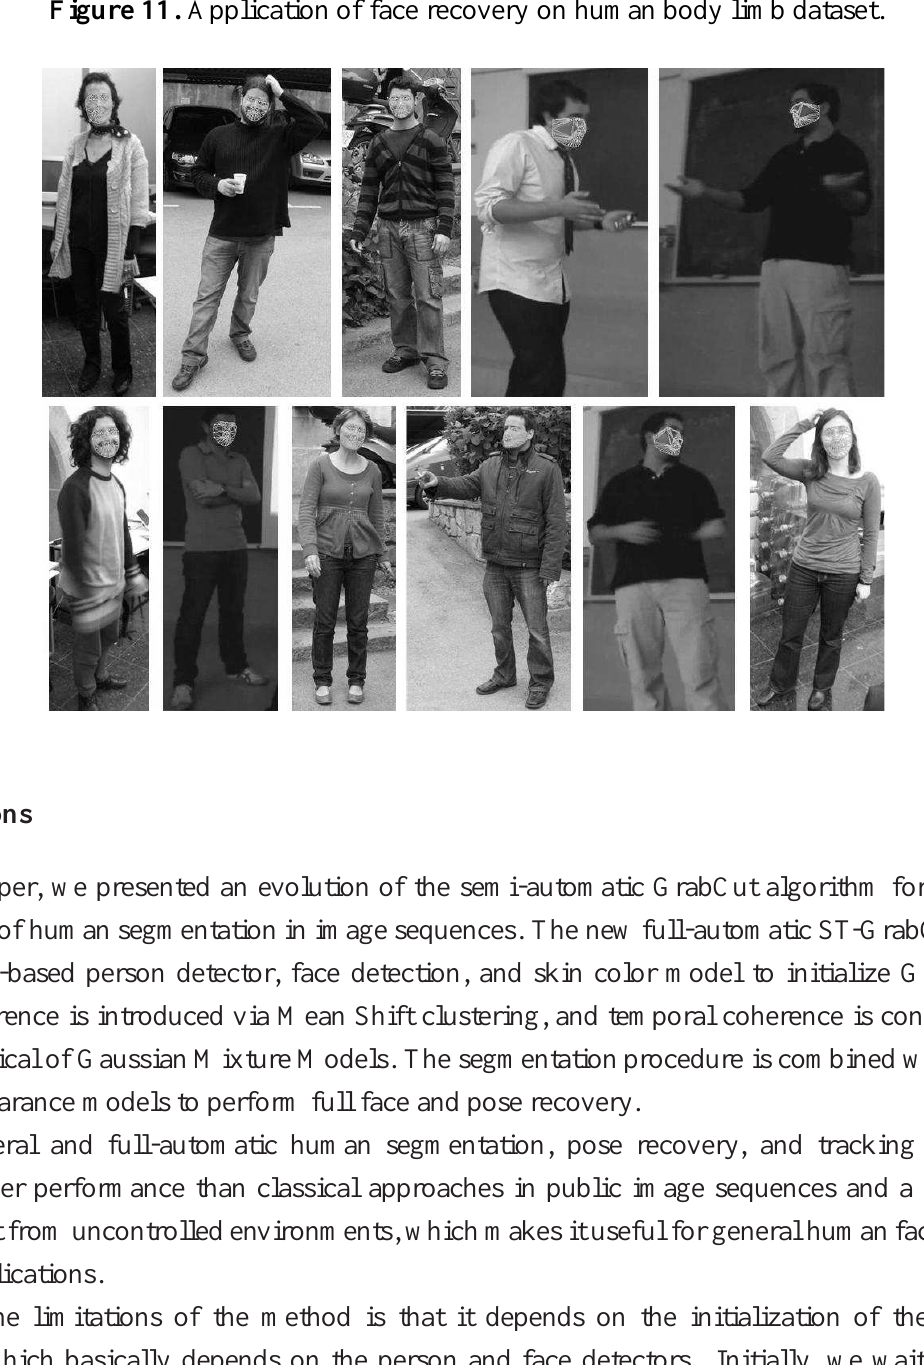
Figure 11. Application of face recovery on human body limb